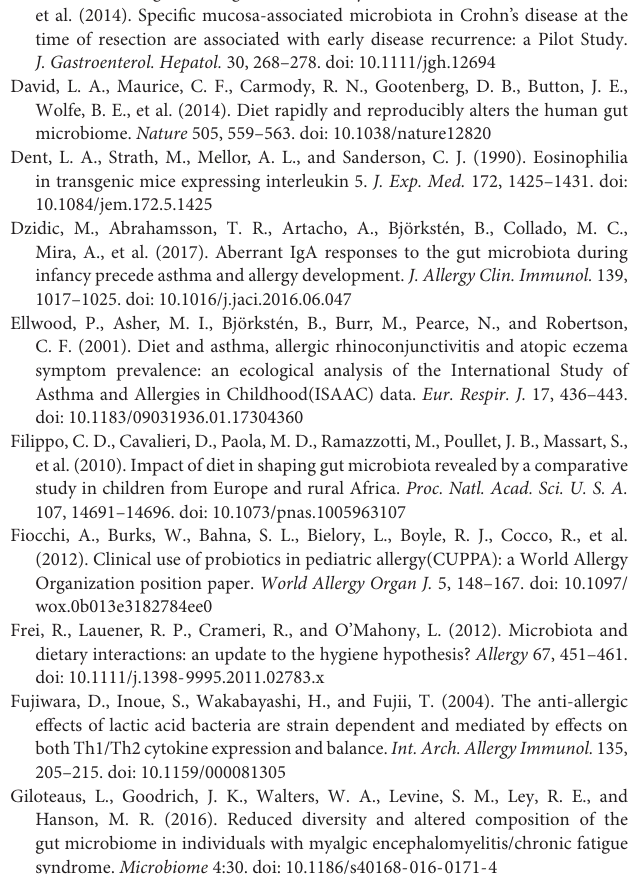
Supplementary Figure 1 | The ratio of IL-4/IFN- γ . Supplementary Figure 2 | Gut microbiota comparisons between Con group and Model group. Supplementary Figure 3 | Gut microbiota comparisons between Model group and Probio group. Supplementary Figure 4 | Gut microbiota comparisons between Probio group and Hfat group. Supplementary Figure 5 | Gut microbiota comparisons between Probio group and Hfiber group. Supplementary Table 1 | Diet